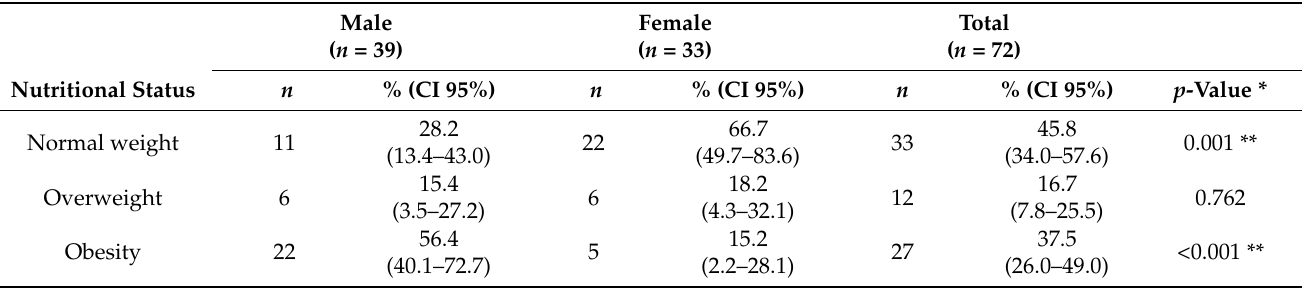
Table 3. Nutritional status of the study population according to BMI Z-score in Huatusco, Veracruz, Mexico.